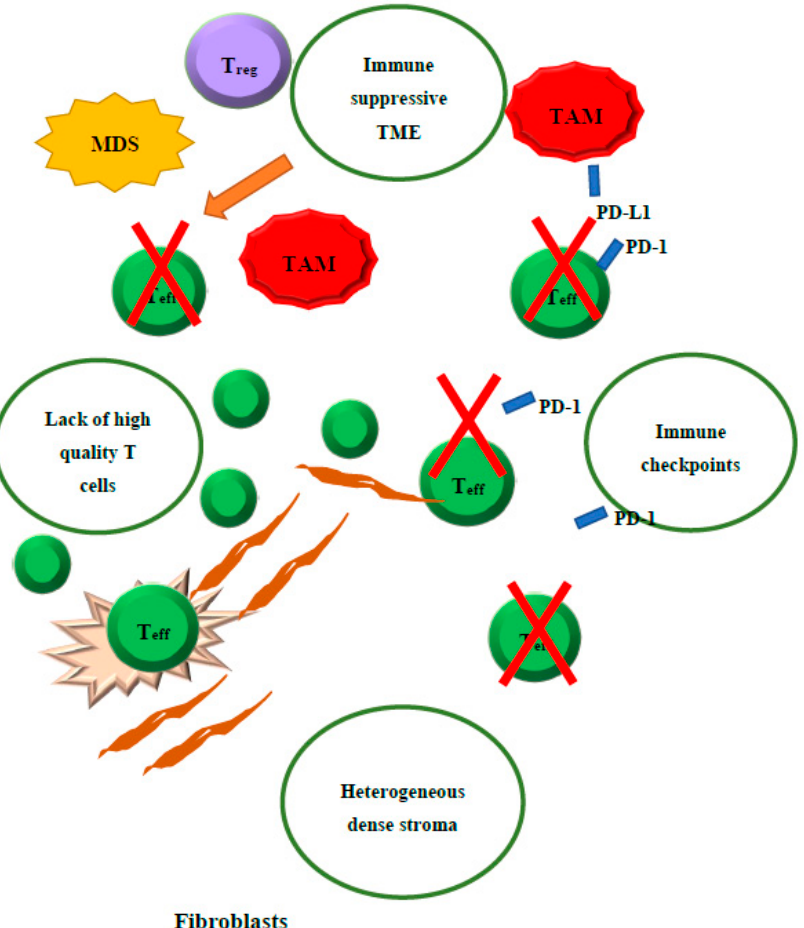
Figure 1. Illustration of the four main immune “defects” in pancreatic cancer.